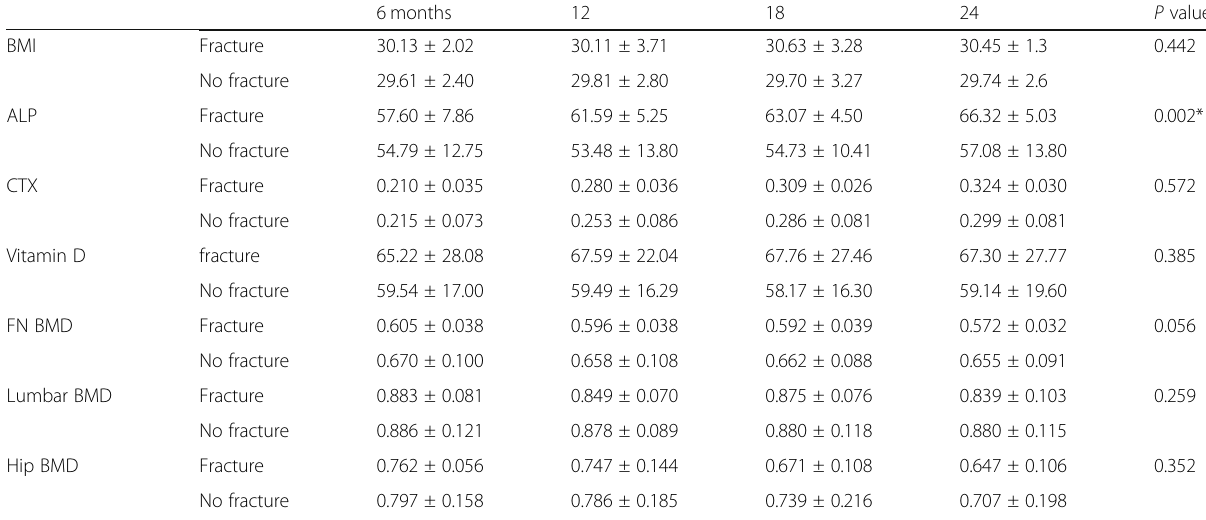
Table 2 Follow-up measurements during drug